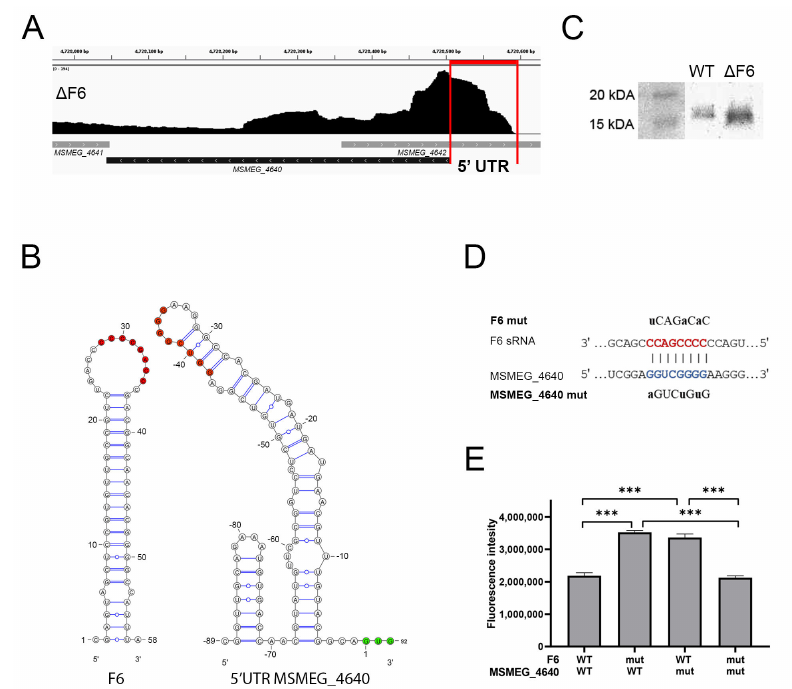
Figure 3. F6 of M. smegmatis directly interacts with the 5 (cid:48) -UTR of MSMEG_4640. ( A ) Inhibition of RpfE2 protein expression by F6. The wt and ∆ F6 cultures were analyzed for RpfE2 expression by Western blotting using antibodies against the Rpf conserved domain. The RpfE2 molecular mass is 15.1 kDa according to Mycobrowser data (https://mycobrowser.epfl.ch/genes/MSMEG_4640, accessed on 28 June 2021). ( B ) The coverage track of the MSMEG_4640 locus in Integrative Genomics Viewer [25]. RNA-seq data of the ∆ F6 strain in the mid-log growth phase are shown. The 5 (cid:48) -UTR is marked by vertical red lines. ( C ) Secondary structures of F6 and the 5 (cid:48) -UTR of MSMEG_4640 . The interacted nucleotides are shown as red dots; green dots mark the start codon. ( D ) Schematic representation of the interaction between F6 and its target MSMEG_4640 . The F6 seed region is in red and the complementary 5 (cid:48) -UTR region is in blue. The introduced mutations are shown above and below. ( E ) The reporter assay illustrating the direct regulation of MSMEG_4640 by F6. The 5 (cid:48) -UTR of MSMEG_4640 was fused to the GFP gene and reciprocal mutations were introduced in the putative interaction sites on F6 and MSMEG_4640 -GFP. GFP translation was estimated by fluorescence. The data are presented as the mean ± SD of three biological replicates for each strain; *** p <